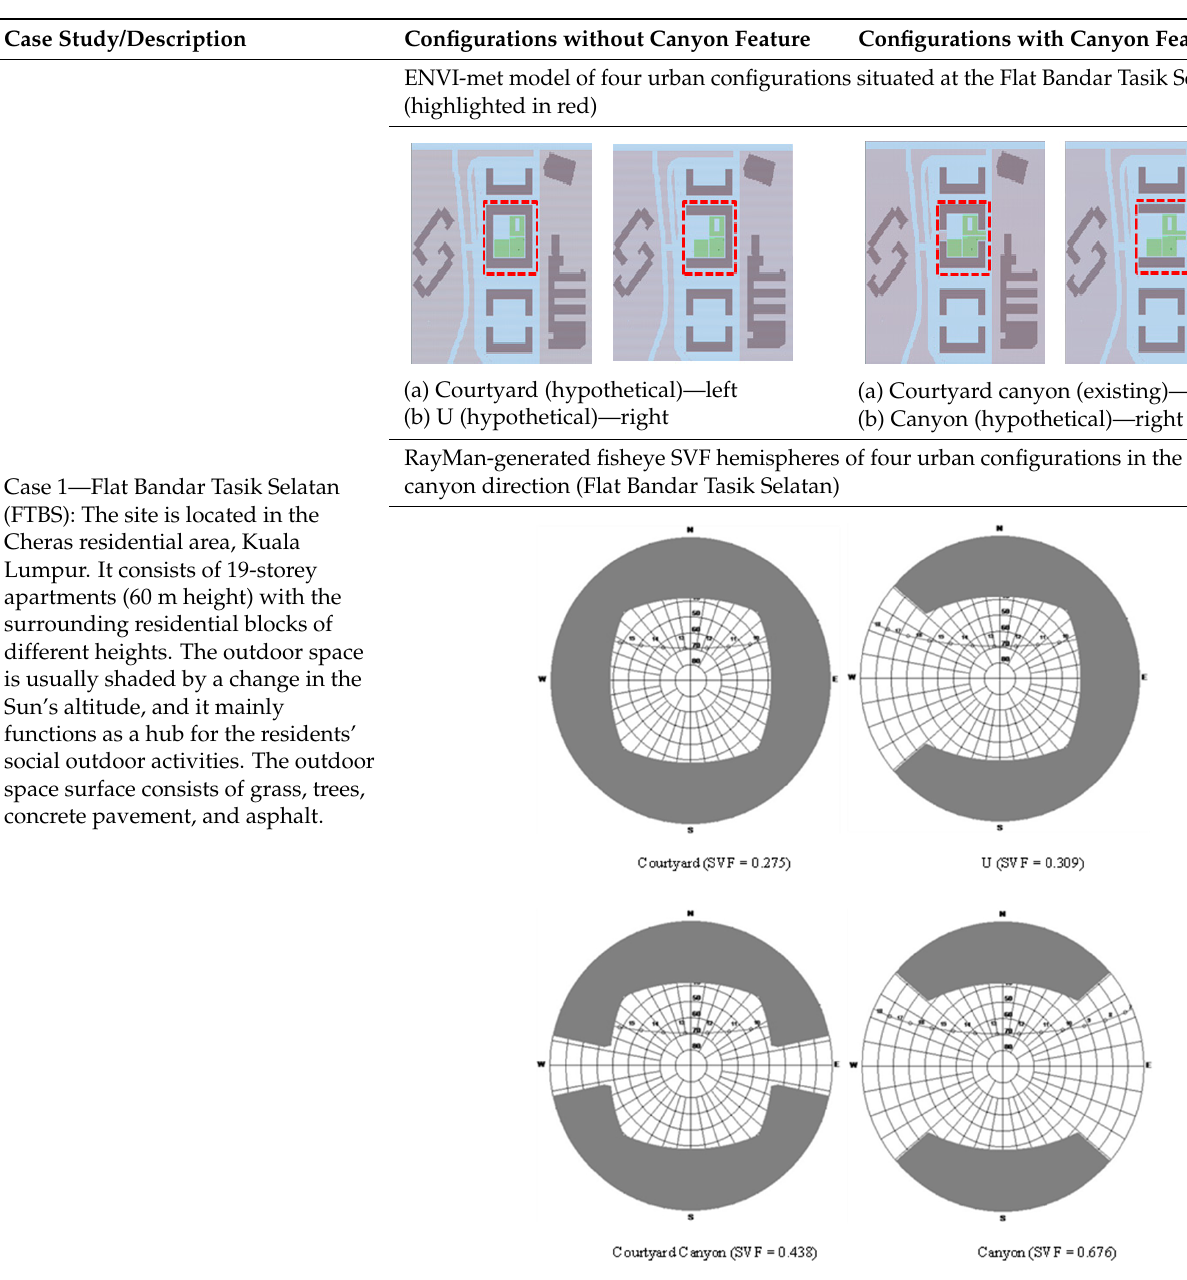
Table 3. Summary of the main features of the case